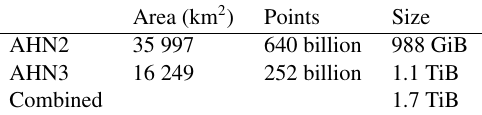
Table 1. Acquisition years and average data density of the three available iterations of AHN. Point densities for AHN2 and AHN3 were determined over the study area (9 tiles).